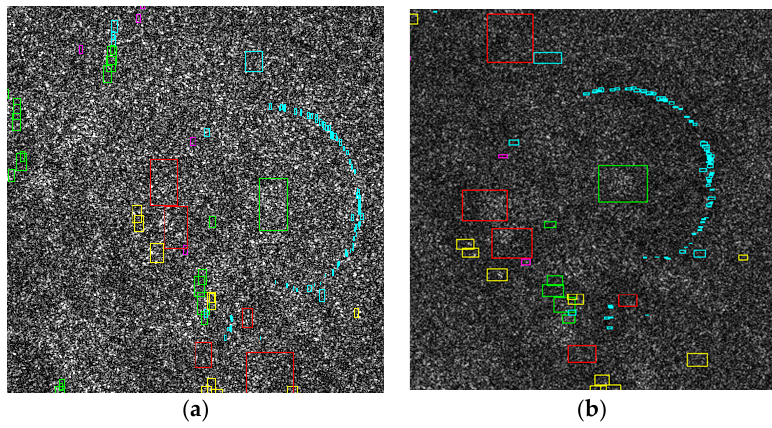
Figure 7. Cluster of Scythian kurgans, Saka kurgans , and ogradkas in the TSX SL images from 12 July 2015 ( a ) and 14 July 2015 ( b )—flipped vertically and horizontally for better comparability (SAR image © DLR, 2015). ( Saka kurgans = red, Scythian kurgans = green rectangle, ogradkas = purple, undatable mounds = yellow, and all other objects = cyan).